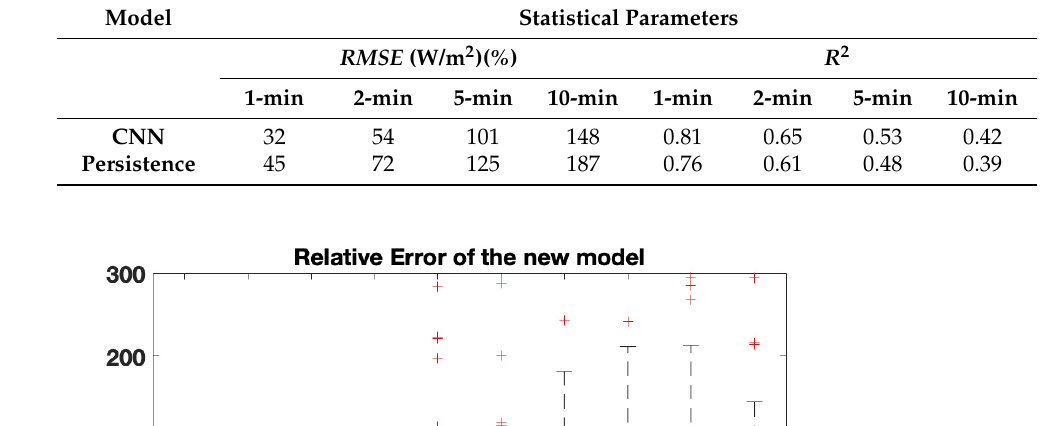
Figure 5. Comparison results of the simulation performed by the new and persistence model and the measured dataset at one-minute intervals; ( a , b ) show a good performance; R 2 = 0.82 and R 2 = 0.74, respectively, for the first two minutes. For the persistence model, R 2 = 0.75 and R 2 = 0.67, respectively, for the first two minutes. Table 3. Presentation of the statistical indicator for the comparison between our model and the persistence model. RMSE and the R 2 of all 100 compared cases.